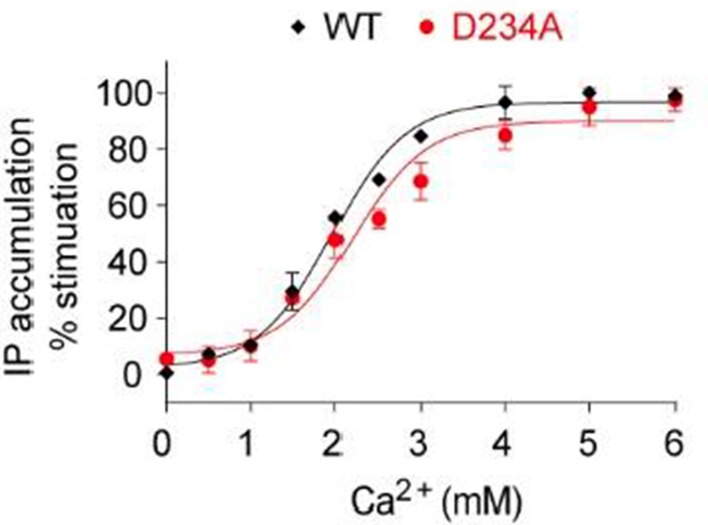
Dose-dependent Ca2+-stimulated IP accumulation in cells transiently expressing the D234A mutant CaSR.